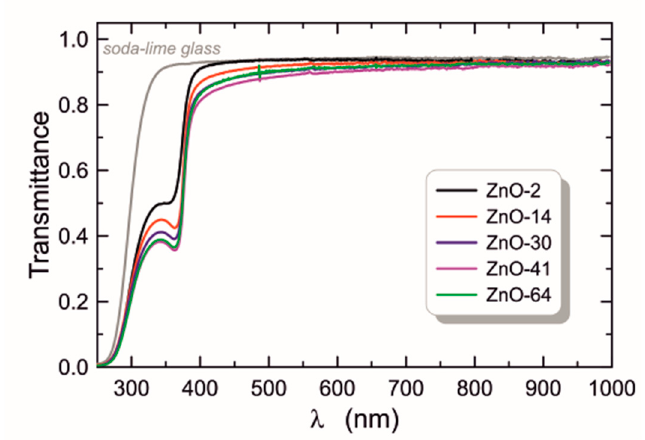
Figure 4. Transmittance characteristics of the layers formed in subsequent days of aging of the ZnO sol.